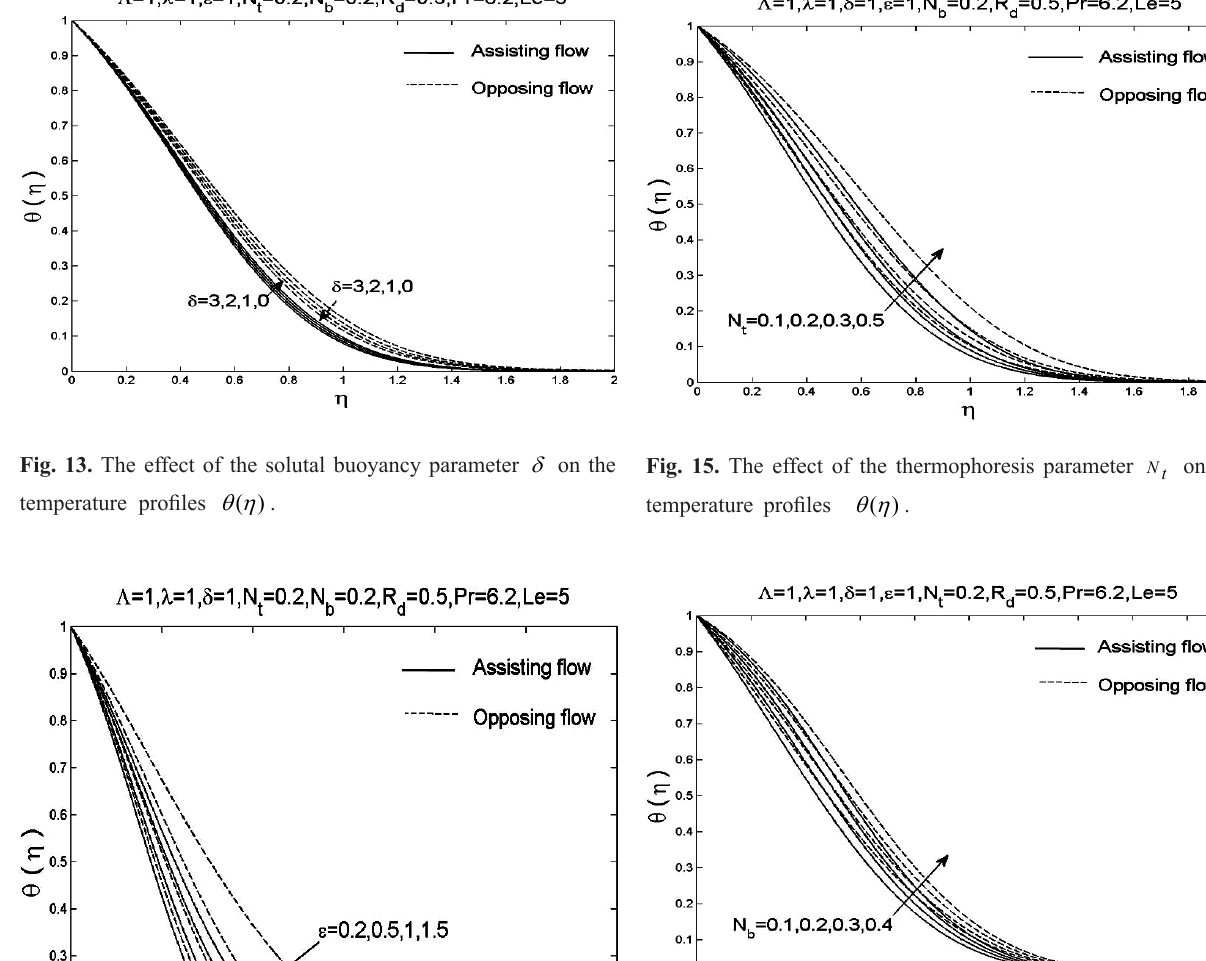
Fig. 16 The effect of the Brownian motion parameter Nb on the temperature profiles ( ) θη .